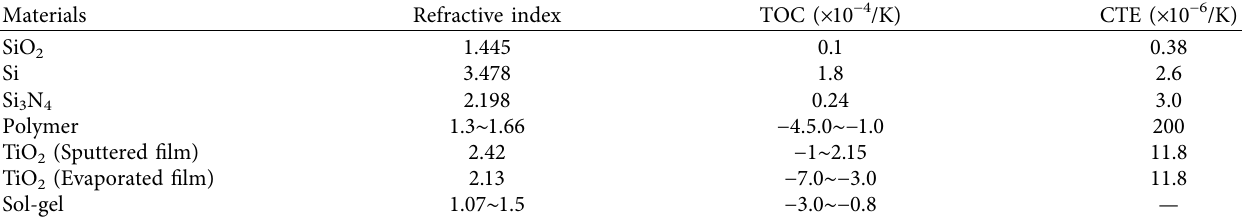
Table 1: Classic materials used in ring resonator-based tunable devices compared with innovative materials on the basis of optical properties to address thermal, polarization, and low tuning efciency while keeping CMOS-compatibility [27, 37].